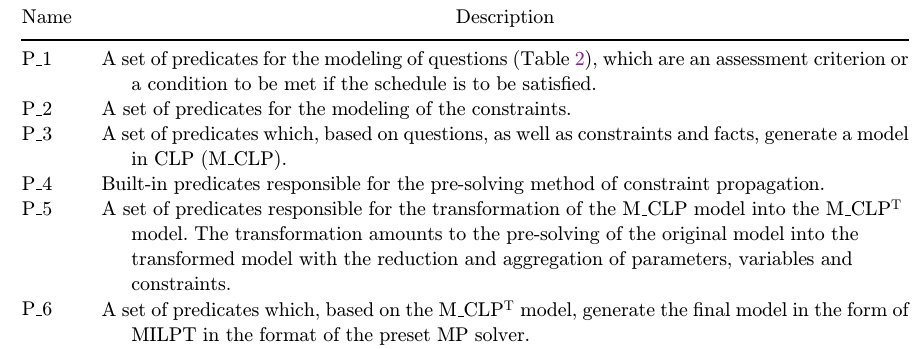
Table 1. The sets of predicates of the